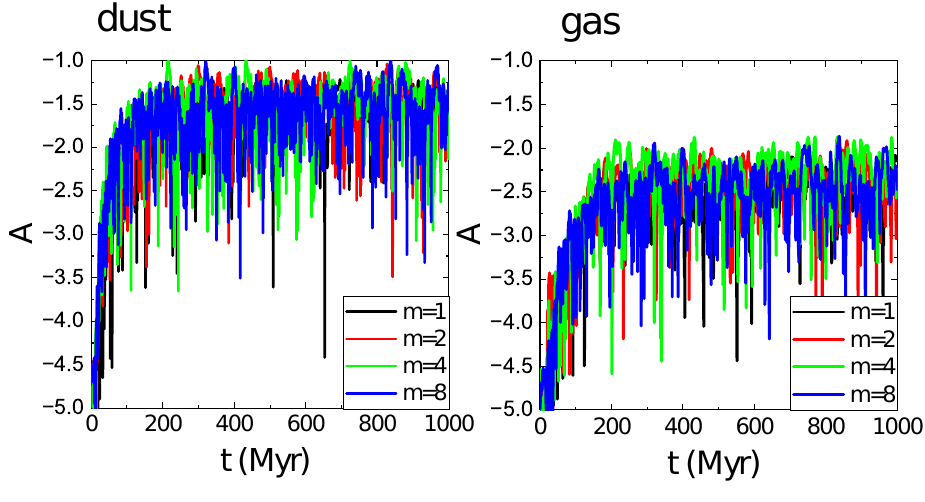
Figure 4. Evolution of global Fourier amplitudes of dust (on the left ) and gas (on the right ) compo- nents in the reference model M233 , for the modes: m = 1—black line, m = 2—red, m = 4—green, and m =